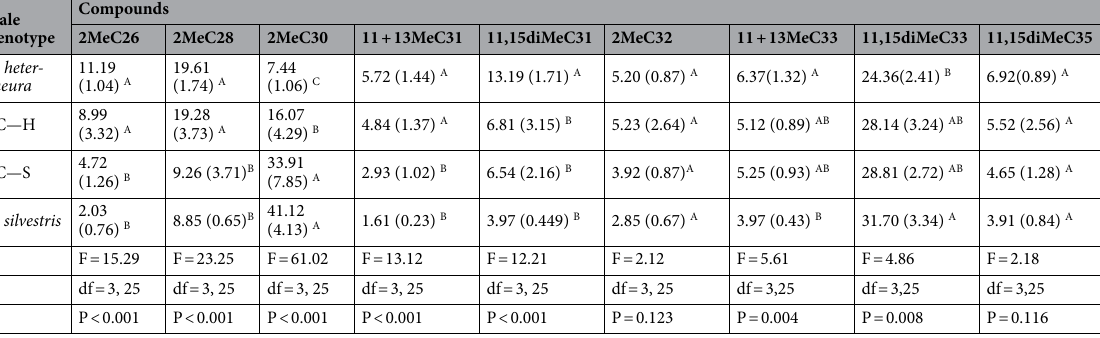
Table 2. Variance (ANOVA) in the major CHCs of D. heteroneura (n = 5), D. silvestris (n = 5), and backcross males: BC—H backcross to D. heteroneura (n = 14), and BC—S backcross to D. silvestris (n = 5). The mean percentage of each compound for each group of males with the standard deviation in parentheses is reported. Means that do not share a letter are significantly different following Tukey’s multiple comparison tests (P < 0.05)).